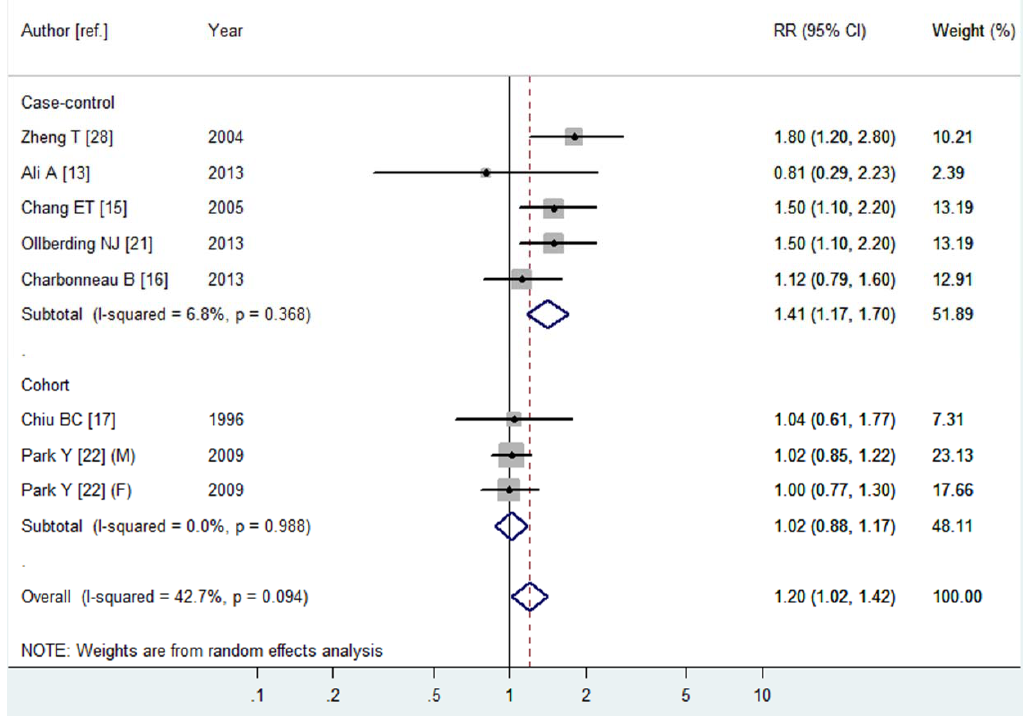
Figure 2. Forest plot of total dairy product consumption and the risk of NHL. The size of gray box is positively proportional to the weight assigned to each study, and horizontal lines represent the 95% confidence intervals. Nutrients 2016 , 8 , 120